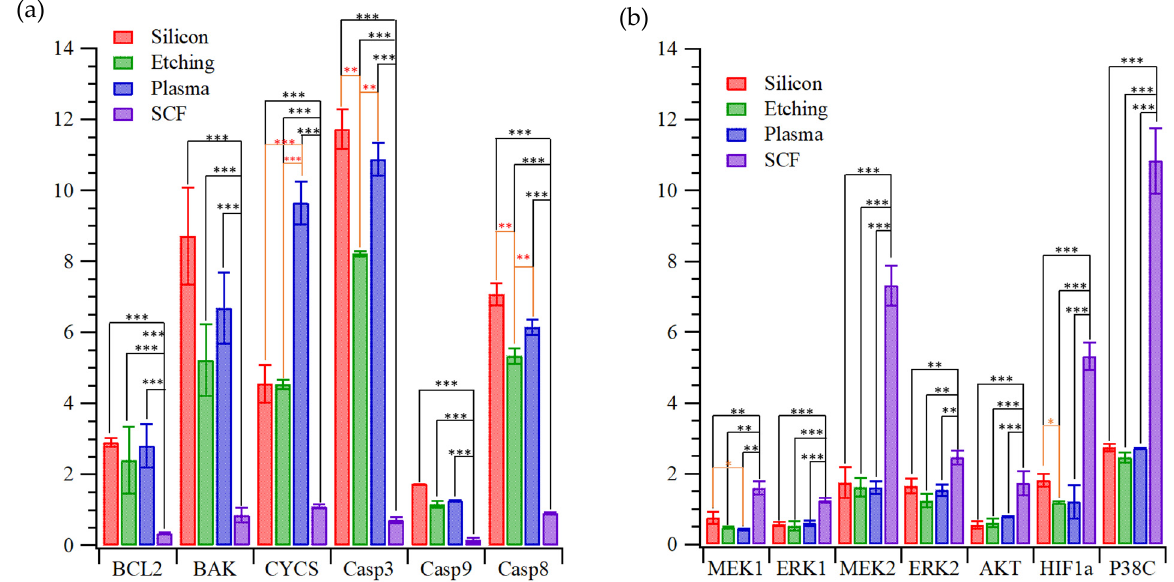
Figure 5. Expression levels (relative to TCPS controls) of key factors in ( a ) apoptosis or ( b ) angiogenesis pathways of H9c2 cells grown on the silicon substrate, after etching, plasma treated, or scCO 2 treated (* p < 0.05, ** p < 0.001, *** p < 0.0005)